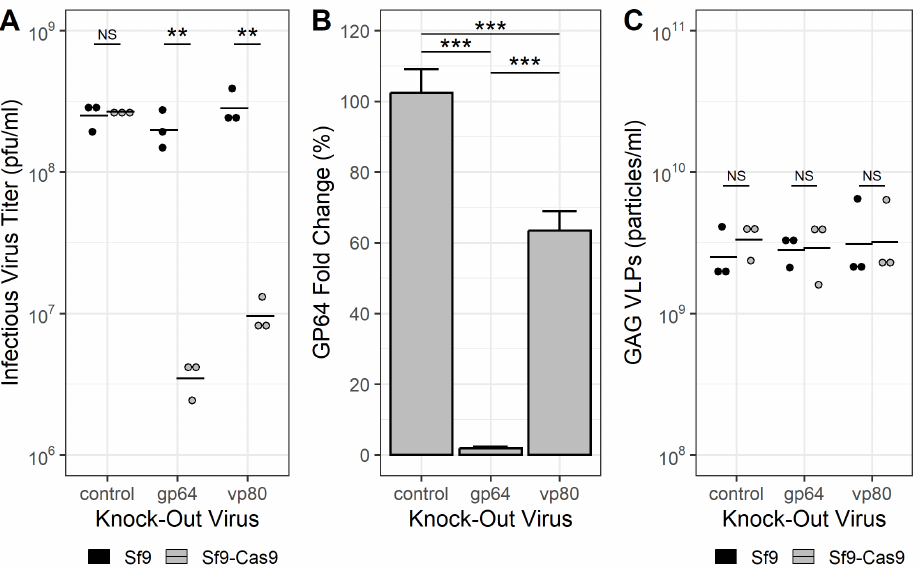
Figure 4. Disruption of the gp64 gene reduces rBEV contamination more than disruption of the vp80 gene. ( A ) gp64 -KOVs produce less budded virus than vp80 -KOVs as measured by IVT in Sf9-Cas9 cells but were both similar to the control with parental Sf9 cells. ( B ) Abundance of GP64 in infected cell membranes of Sf9-Cas9 cells was significantly lower for gp64 KOVs compared to parental Sf9 cells. Targeting the vp80 gene also had an apparent effect on GP64 abundance in the membrane. ( C ) Yield of HIV-1 Gag VLPs was not significantly different for any KOVs in either Sf9-Cas9 or Sf9 cells. All samples were taken at 48 hpi. ** p < 0.01, *** p <